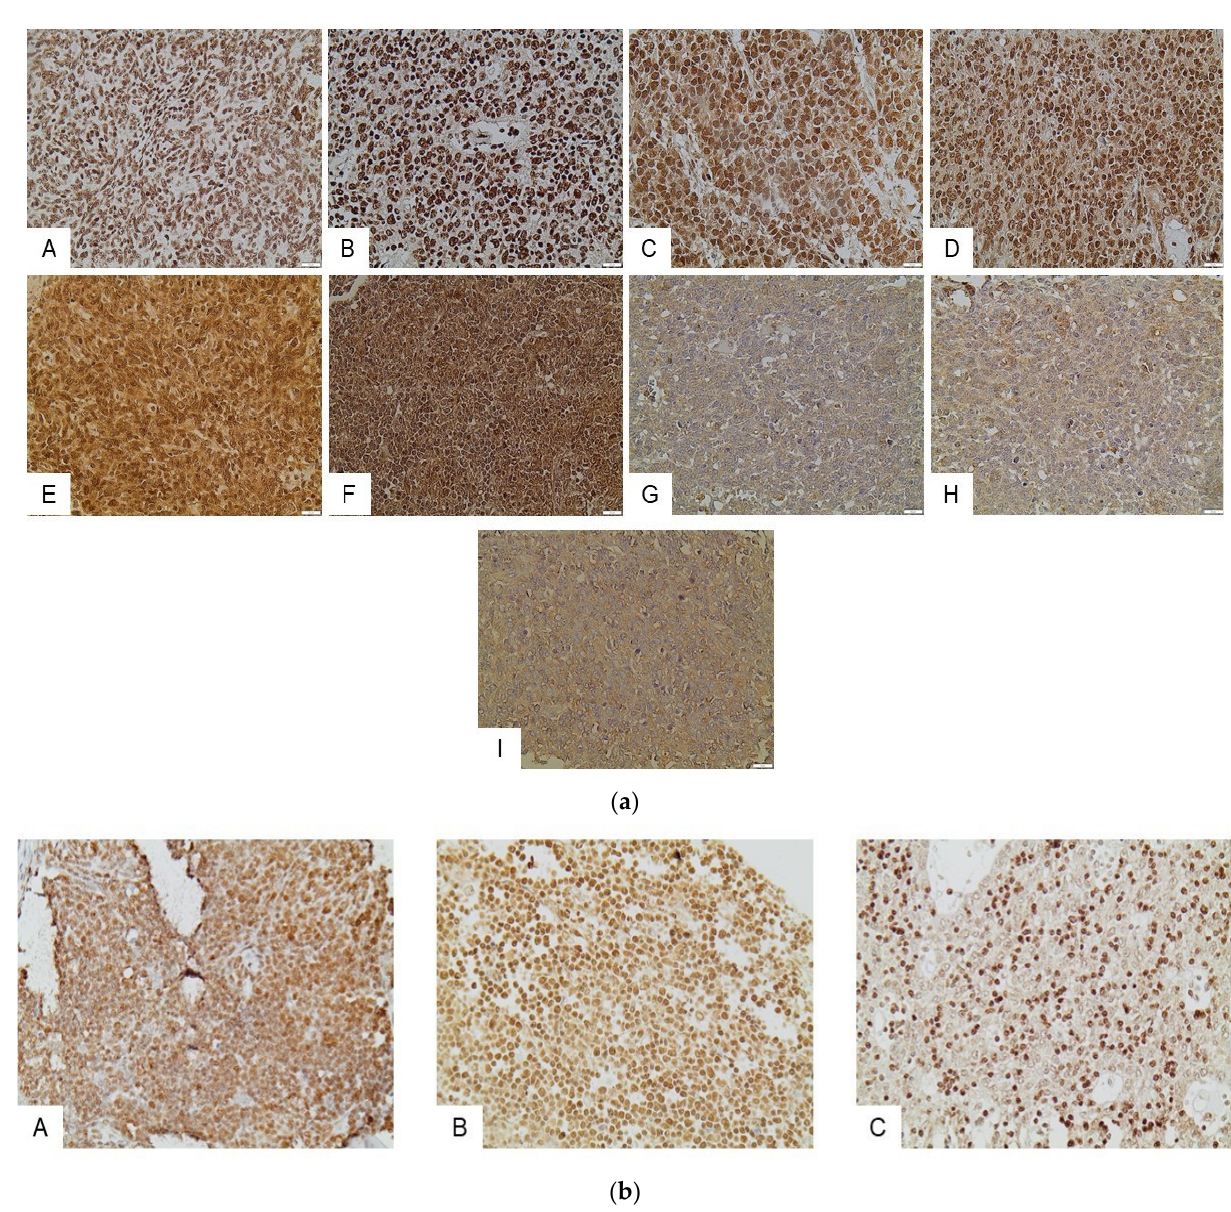
Figure 1. ( a ) Immunohistochemical expression of HDACs in the epithelial component of TETs. HDAC1 in an A type thymoma (nuclear) ( A ), and in a thymic carcinoma (nuclear) ( B ). HDAC2 in a thymic carcinoma (nuclear and cytoplasmic) ( C ), and in a B3 type thymoma (nuclear and cytoplasmic) ( D ). HDAC3 in a thymic carcinoma (nuclear and cytoplasmic) ( E ), and in a thymic carcinoma (nuclear and cytoplasmic) ( F ). HDAC4 in a type A thymoma (cytoplasmic). ( G ) HDAC5 in a type A thymoma (cytoplasmic) ( H ), and HDAC6 in a thymic carcinoma ( I ). All pictures are at ×400 magnification. ( b ) Immunohistochemical expression of HDACs in the lymphocytic component of TETs. HDAC1 in a B1 type thymoma (nuclear) ( A ). HDAC2 expression in an A type thymoma (nuclear) ( B ), and HDAC3 expression in a B2 type thymoma (nuclear) ( C ). All pictures are at ×400 magnification.